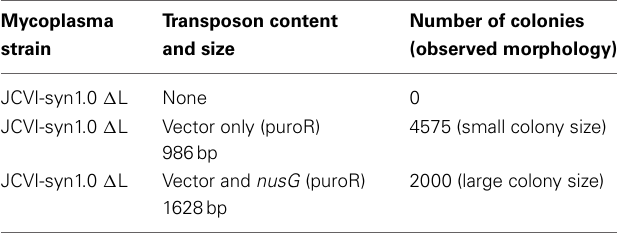
Table 1 | Colony counts from complementation of JCVI-syn1.0 (cid:2) L using the marker-driven approach.